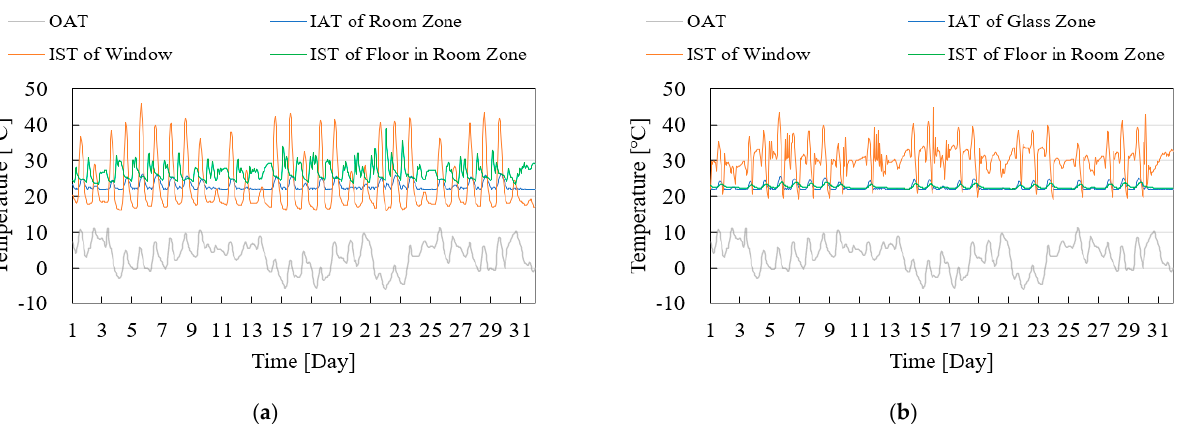
Figure 7. Outdoor air temperature (OAT), indoor air temperature (IAT), and interior surface tem- perature (IST) of window and floor for the ground floor model. ( a ) Radiant floor heating system; ( b ) Heated window heating system.